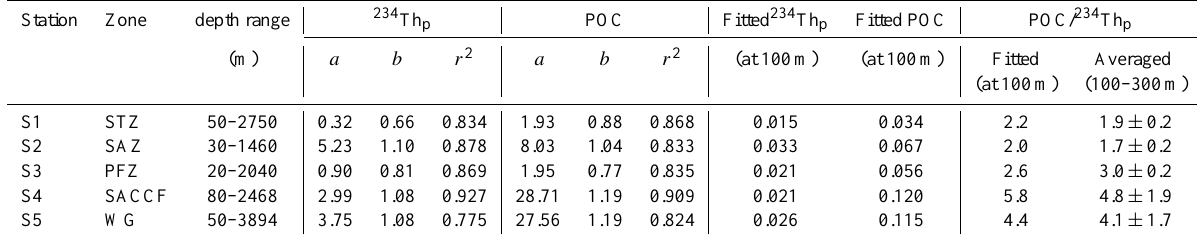
Table 2. Summary of the power law parameters for the vertical POC and particulate 234 Th activity profiles for > 53µm particles at Super stations S1 to S5. The used fitting function is y = a Z -b , where y = POC concentrations in µmolL − 1 and 234 Th p activity in dpm L − b and Z = depth. Also listed are fitted values of POC concentration and 234 Th p activity at 100m for > 53µm particles and estimated POC/ 234 Th p ratio (µmoldpm − 1 ) . These are compared with POC/ 234 Th p ratios obtained from averaging approach (see text for